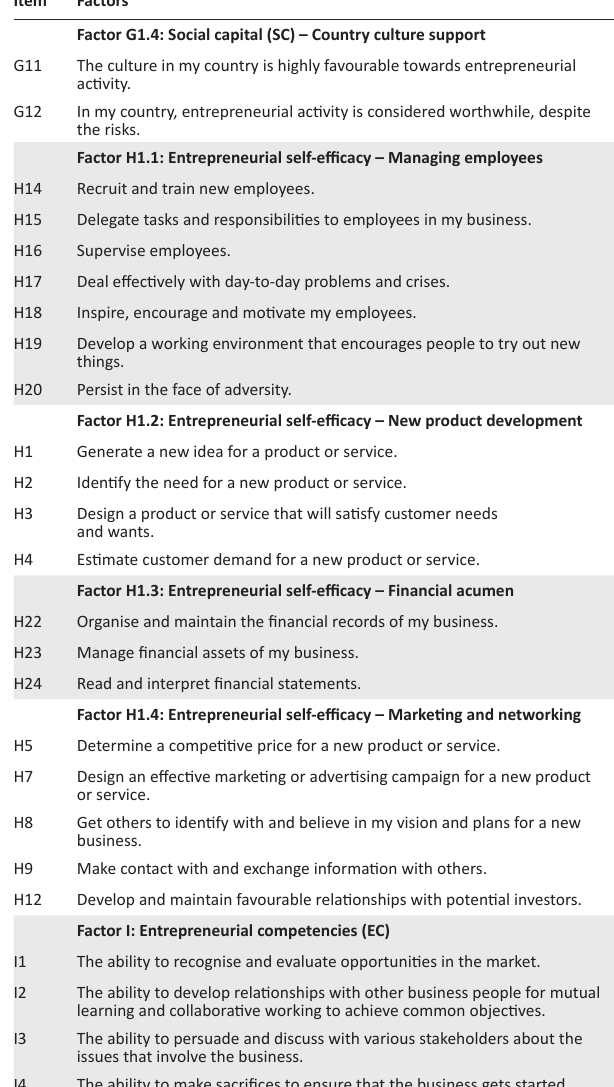
TABLE 6 (Continues...): Factors extracted from the seven scales and their items.